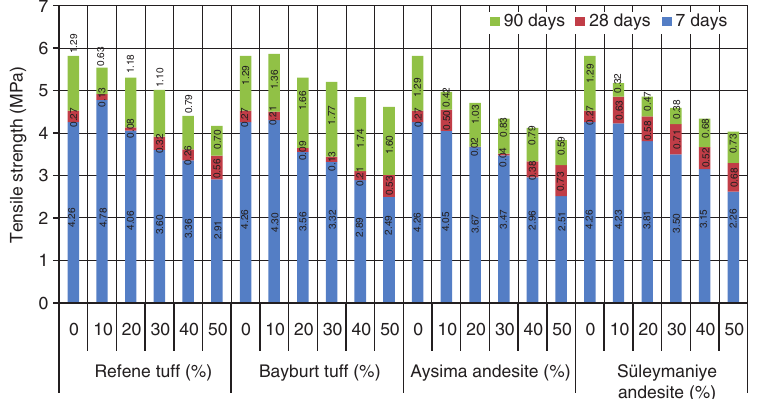
Figure 4 Tensile strength values of the samples at the end of 7, 28, and 90 days.